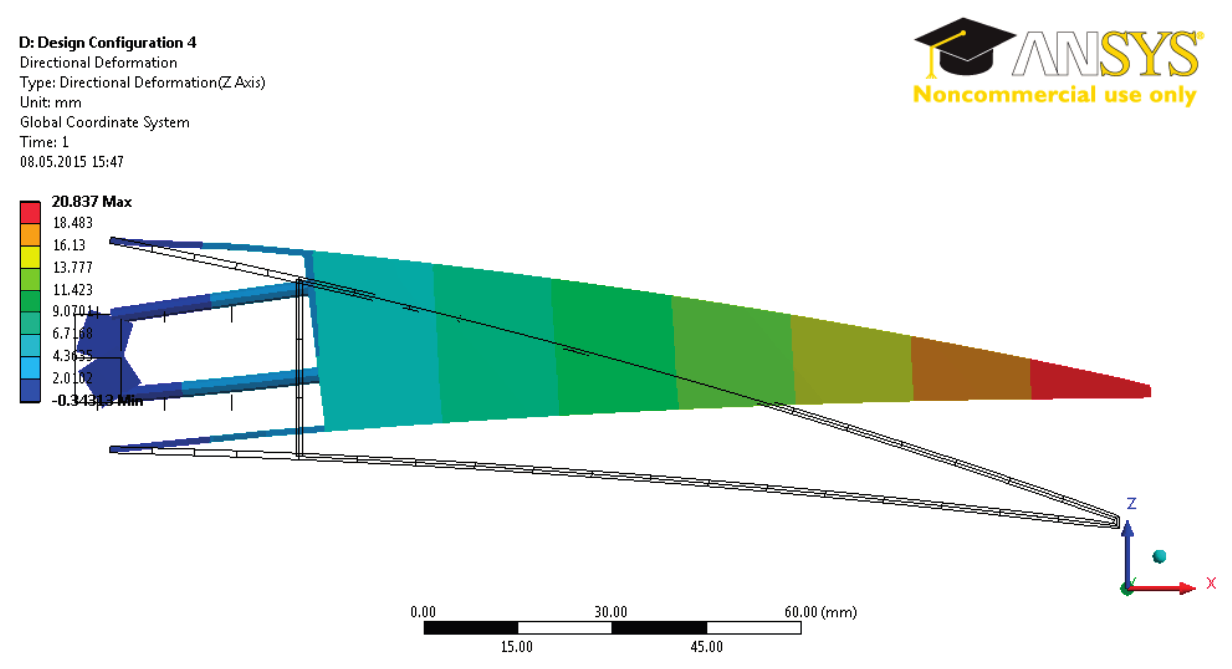
Figure 23. Deformation along Z -axis for design configuration 4.